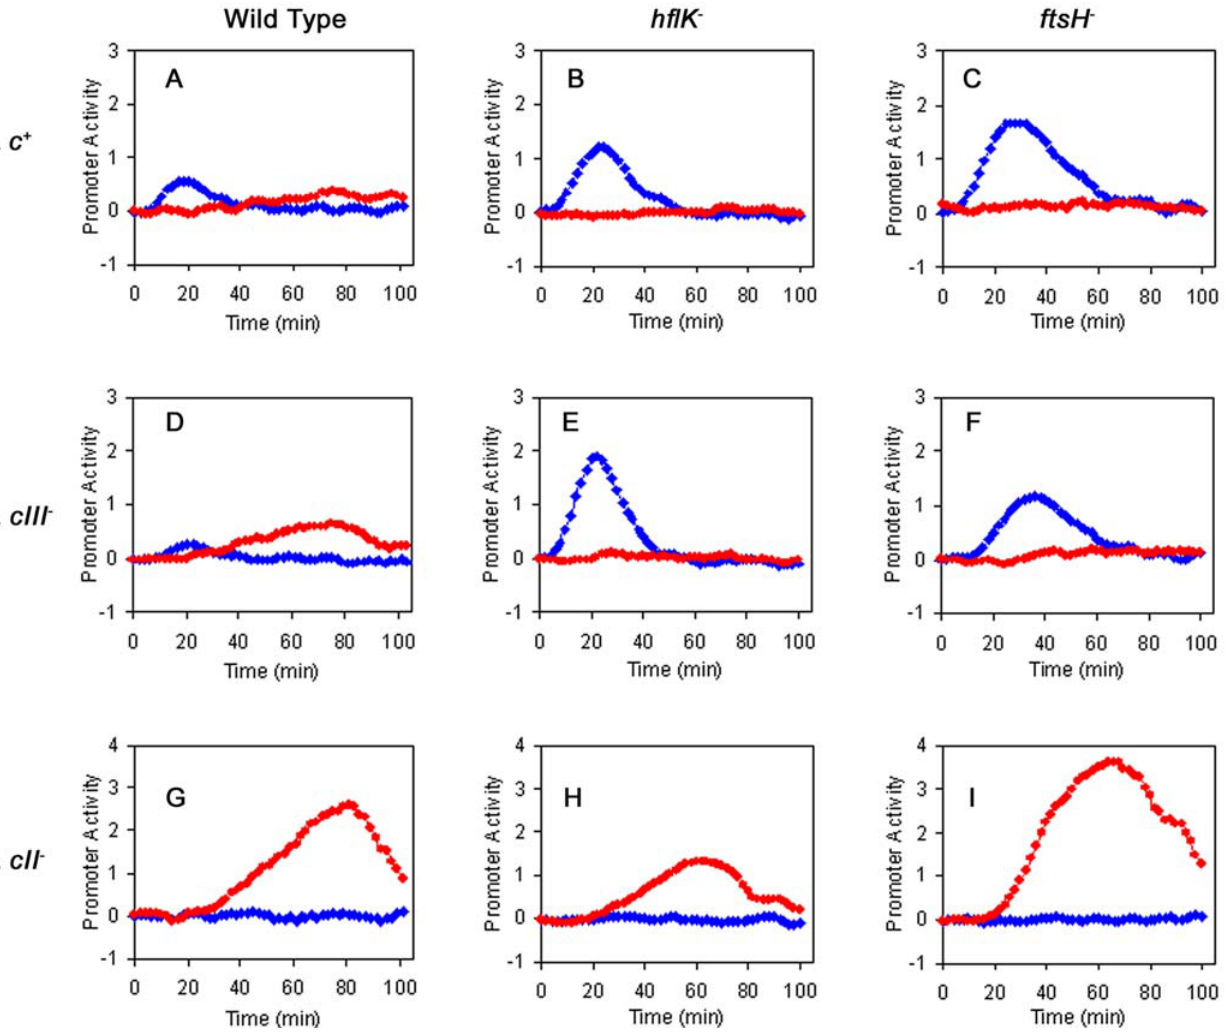
Figure 5. FtsH and HflA affect the l genetic network. CII activity is reported by pE- gfp fusions (blue diamonds), whereas Q activity is reported by pR‘-tR‘- gfp fusions (red circles). The promoter activity as function of time of cultures of wild type strain ( A, D, G ) hflA - strain ( B, E, H ) or ftsH deleted strain ( C, F, I ) infected with l c + ( A, B, C ), l cIII 2 ( D, E, F ) and l cII 2 ( G, H, I ) is shown. All experiments were carried out as described in the materials and methods at a MOI of